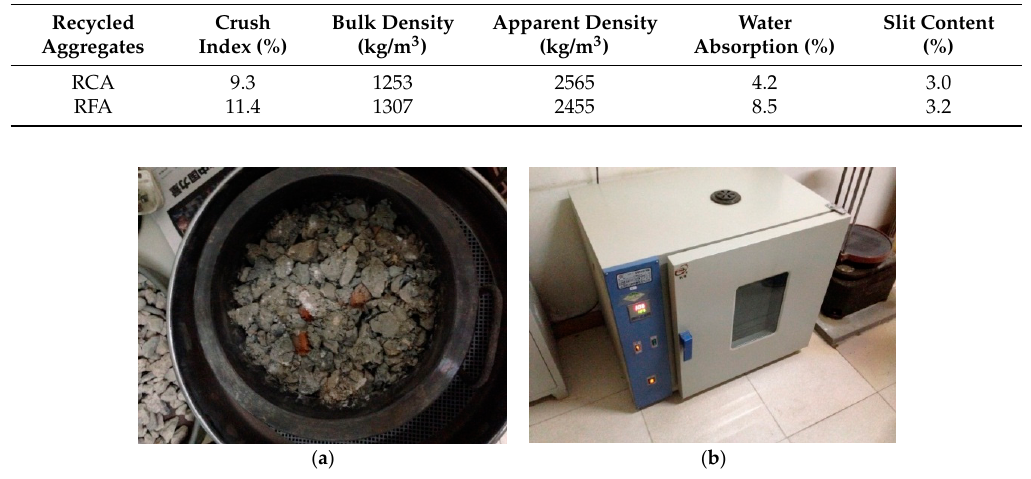
Figure 2. Instruments used for measuring the physical properties of the aggregates. ( a ) Crush index; ( b ) Water absorption.